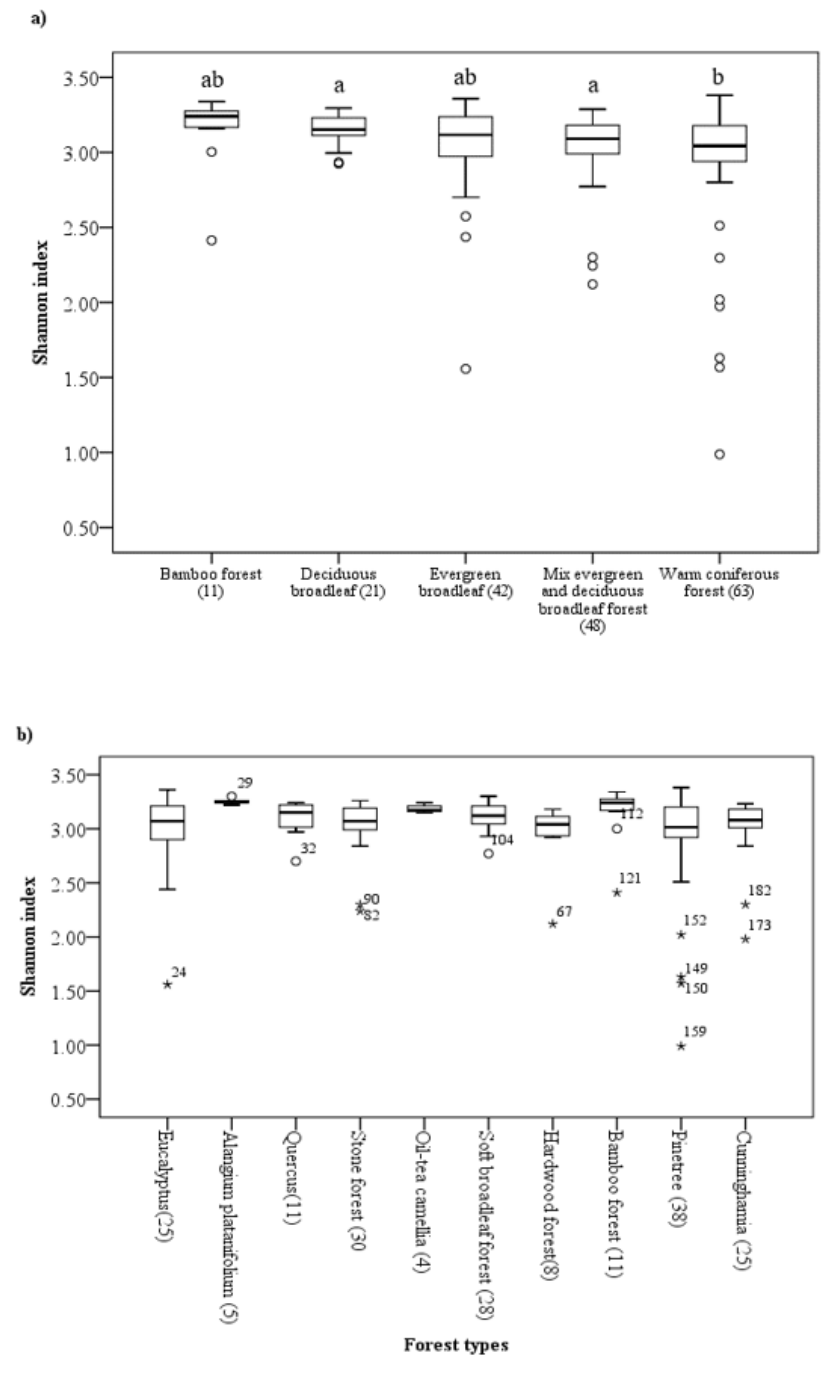
Figure 4. Distribution of the average value of soil microbial metabolic diversity according to ( a ) the biome and ( b ) tree species levels. Numbers in parentheses indicate the number of soil samples. Different letters indicate significant differences between forest types ( p < 0.05). The bars that are above and below the boxes represent the positive and negative standard error, respectively. The line segment at the median inside the rectangular box is treated as the median line. The circles represent mild outliers, and the whiskers represent the extreme outliers.